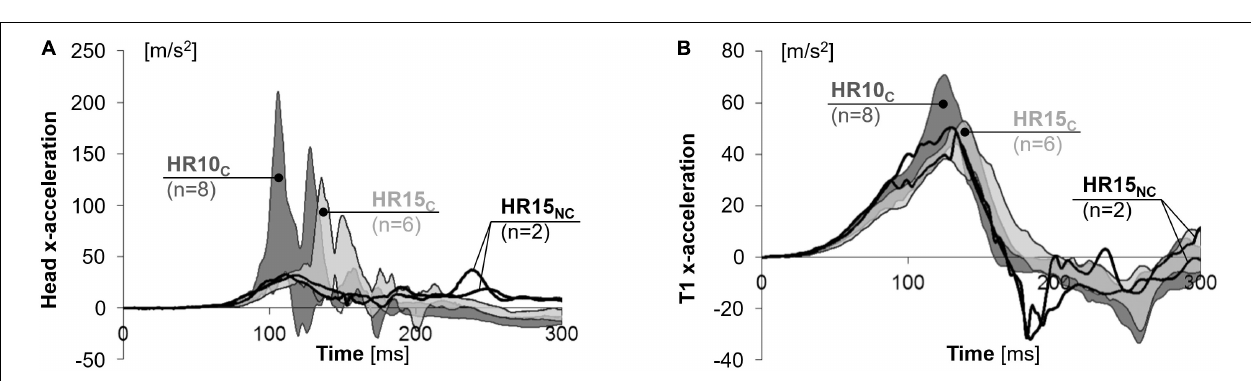
FIGURE 6 | X-accelerations of the (A) head and (B) T1 for near 50th percentile female